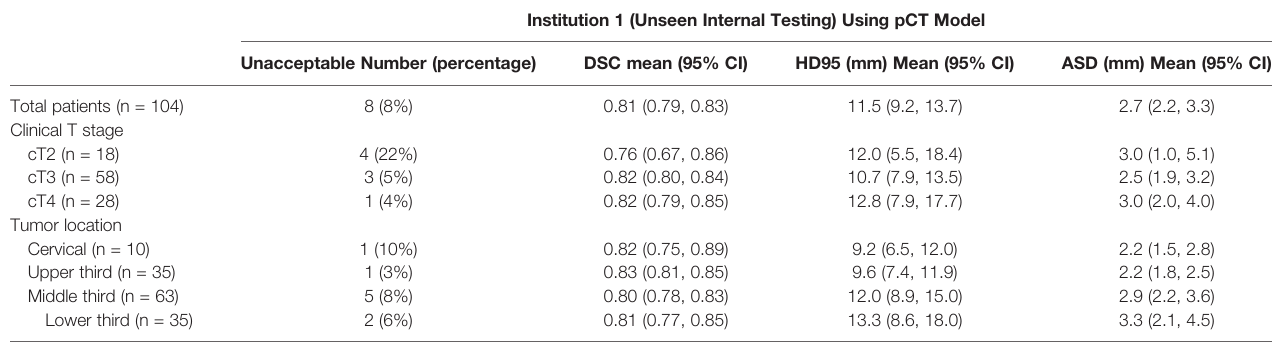
TABLE 2 | Quantitative results of esophageal GTV segmentation by the pCT model in the unseen internal testing data.